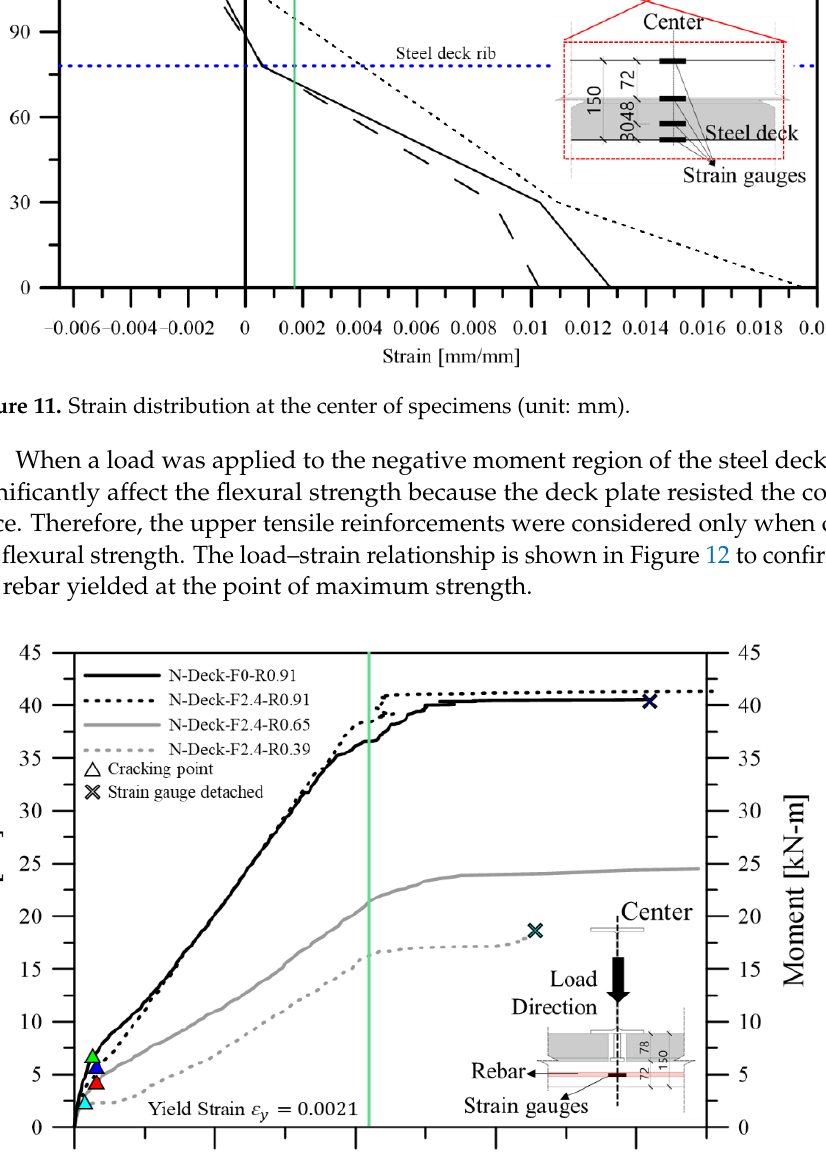
Figure 11. Strain distribution at the center of specimens (unit: mm).